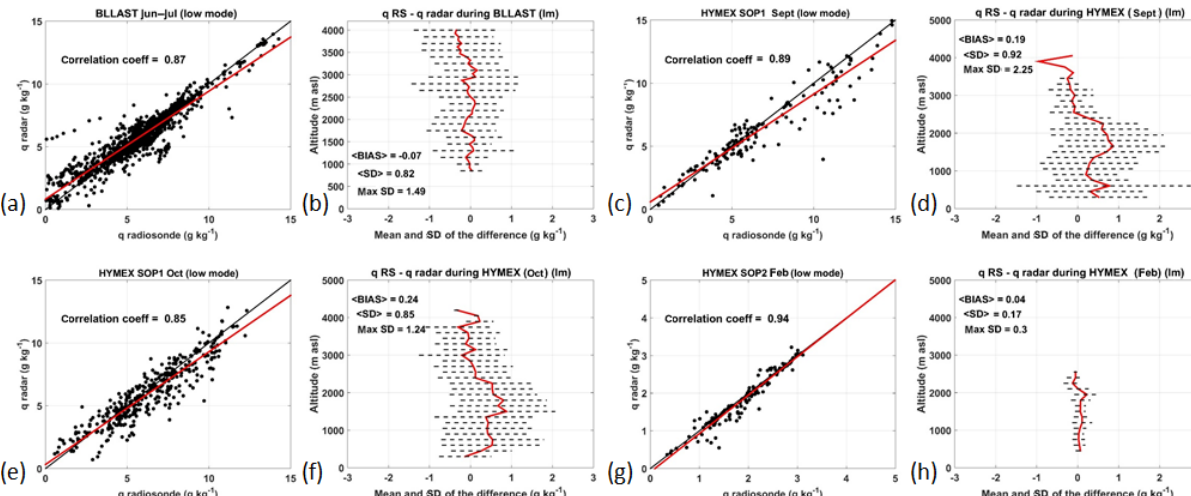
Figure 4. (a, c, e, g) Scatterplots of radar versus RS specific humidity during June and July 2011 (BLLAST), September 2012 (HyMeX SOP1), October 2012 (HyMeX SOP1) and February 2013 (HyMeX SOP2), respectively, with the linear regression line (in red) and the 1:1 slope line (in black). The R 2 correlation coefficient of the regression is also specified. (b, d, f, h) Deviation profiles between the RS specific humidity measurements and radar-based estimate for the above specified data sets ± the standard deviation. The mean bias and standard deviation values for the whole dataset are reported, along with the maximum standard deviation value (gkg − 1